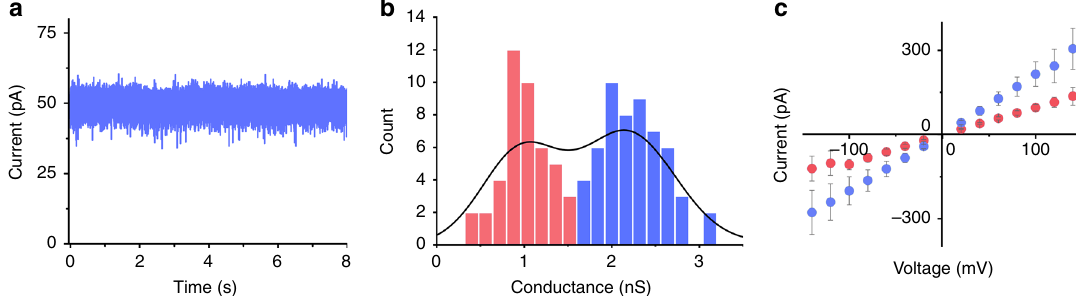
Fig. 3 Electrical recordings con fi rm the membrane-spanning nature of DNA nanopore NP. a Representative ionic current trace of a single nanopore in 1 M KCl, 10 mM HEPES pH 8.0, and at + 20 mV relative to the cis side of the membrane (Fig. 1a). b Histogram of channel conductances obtained from approximately 100 independent single-channel recordings at + 20 mV to + 50 mV. Red and blue indicate the low and high conductance states of pores, respectively. c Current – voltage ( IV ) curves displaying the averages and standard deviations from 10 independent single-channel current traces. The low and high conductance states of the pores are shown in blue and red, respectively. Electrical recordings were measured using the Orbit 16 device which is grounded at the cis chamber. Source data are provided as a Source Data fi le